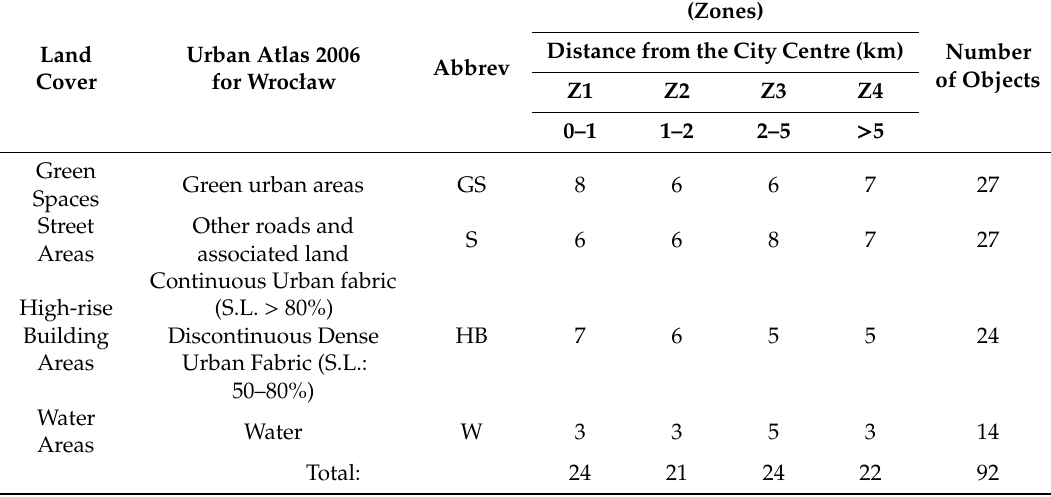
Table 1. Number of objects selected for observation depending on the distance from the reference point and type of land cover (Based on [61]).